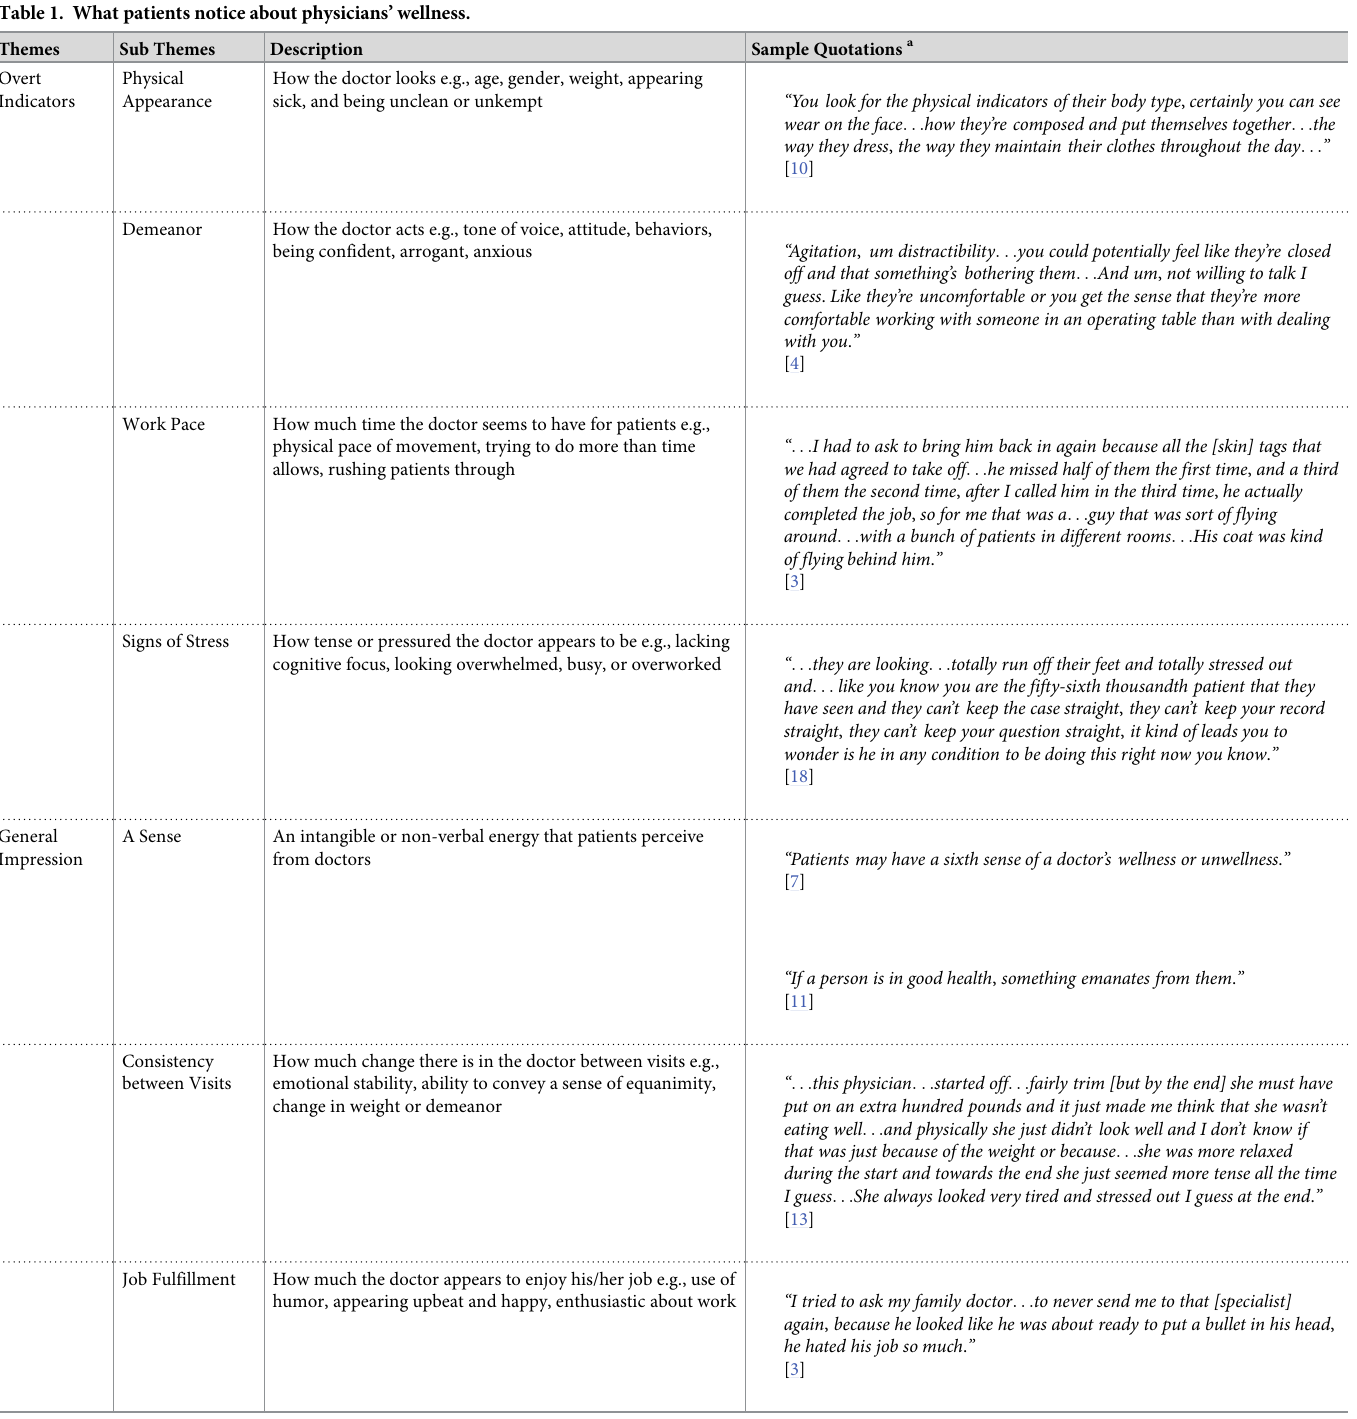
Table 1. What patients notice about physicians’